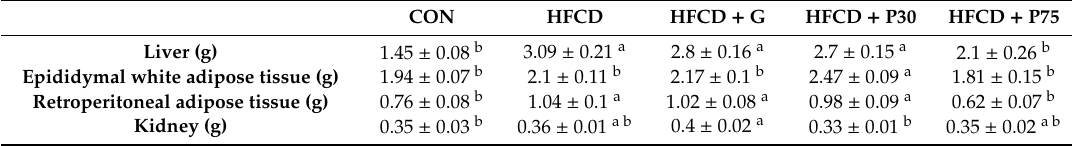
Table 2. E ff ects of PEITC supplementation on liver, adipose, and kidney weight in HFCD. Table 2. Effects of PEITC supplementation on liver, adipose, and kidney weight in HFCD.